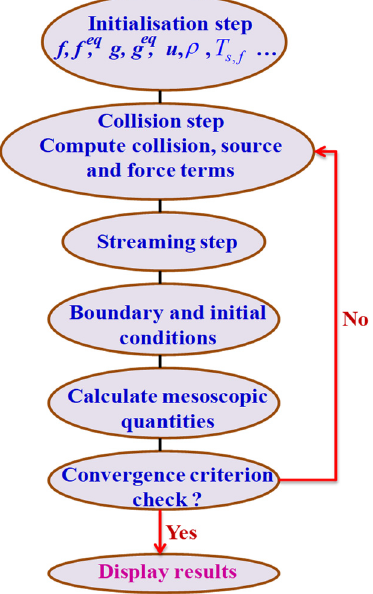
Figure 17. LBM general flowchart.